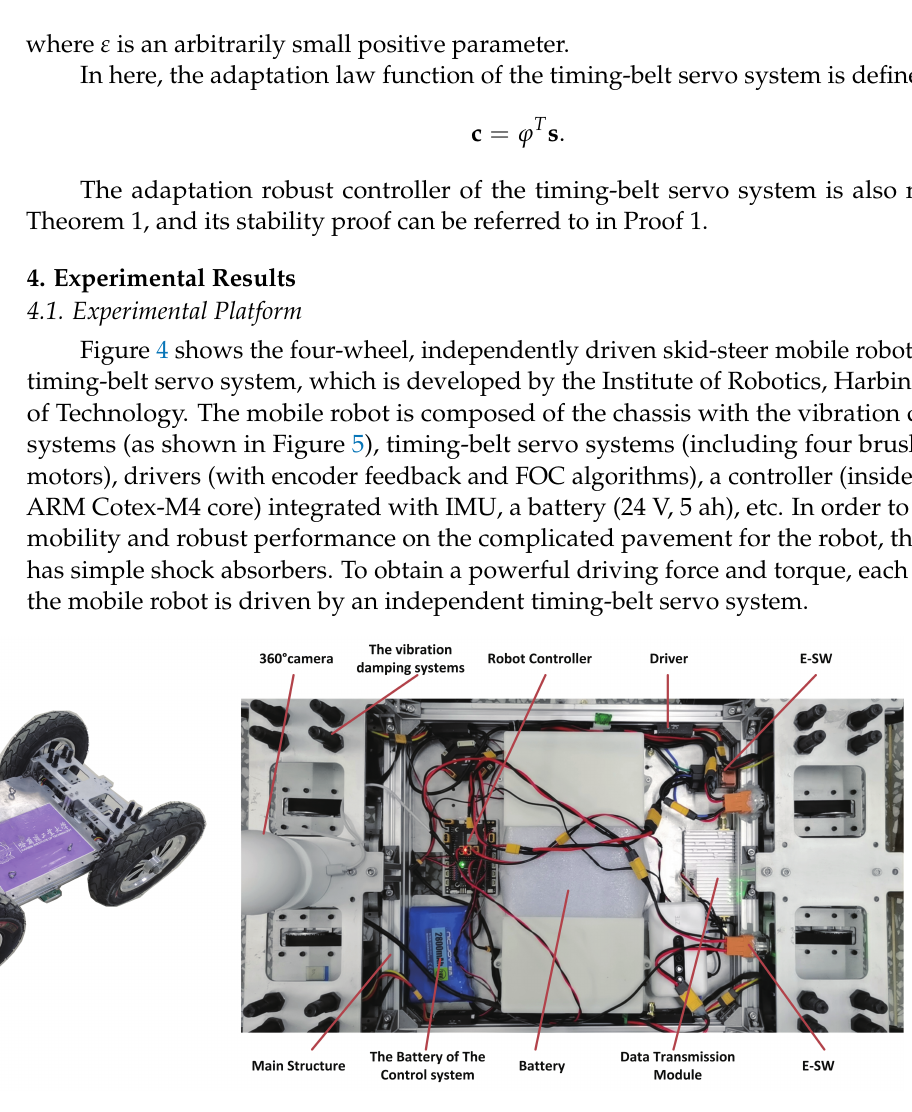
Figure 4. The mobile